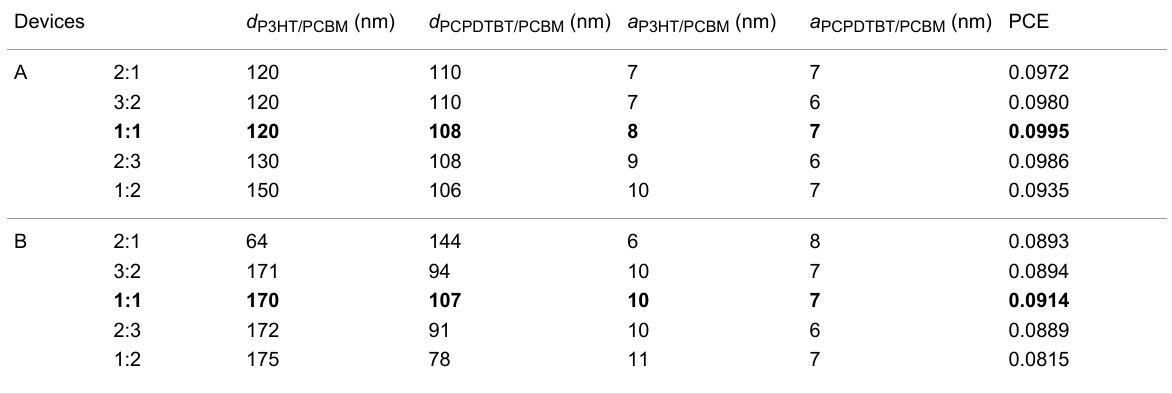
Table 2: Optimized device parameters of both the two configurations in a tandem structure studied herein. Devices